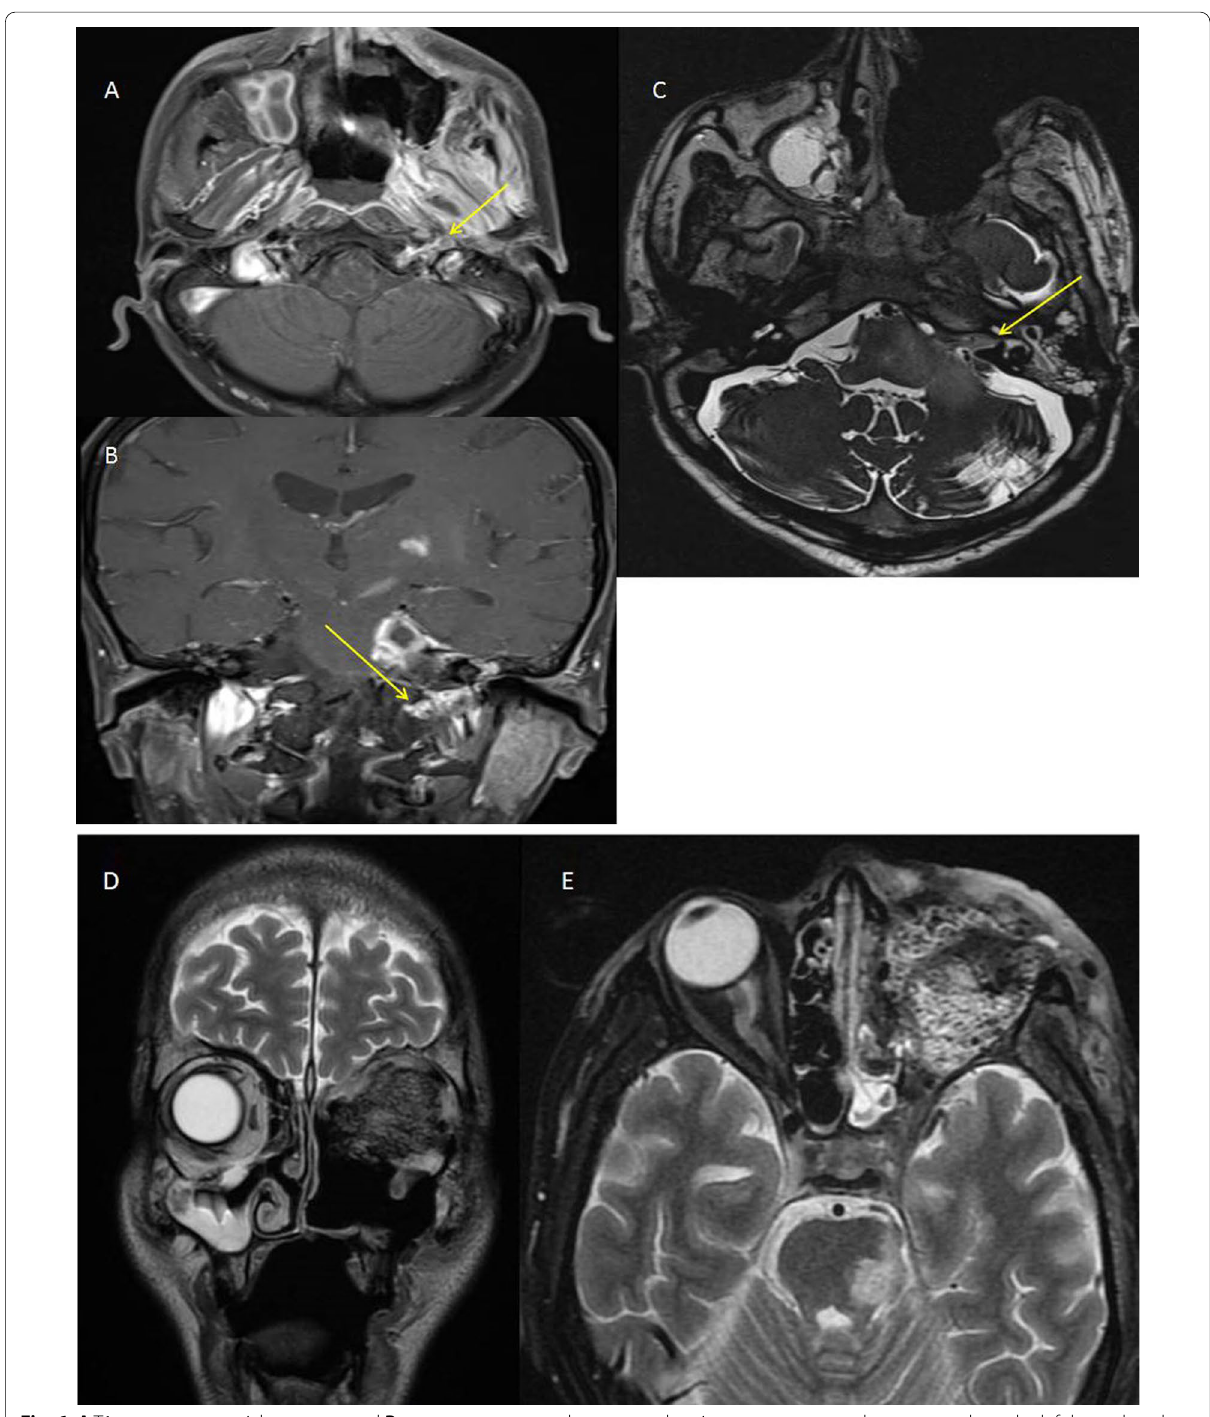
Fig. 6 A T1 post-contrast axial sequence and B post-contrast coronal sequence showing post-contrast enhancement along the left hypoglossal nerve (arrows). MRI showing inflammation along the left CP angle with involvement of seventh and eighth cranial nerves as a result. Thickening and extension of inflammation were seen along the internal acoustic meatus, hypoglossal canal and the left inferior alveolar canal with VII, VIII and XII involvement. C CISS in the axial plane demonstrating thickening of the cisternal segments of the seventh-eighth cranial nerve complex on the left side. D T2 axial and E coronal sequences showing hypointense fungal tissue in the left